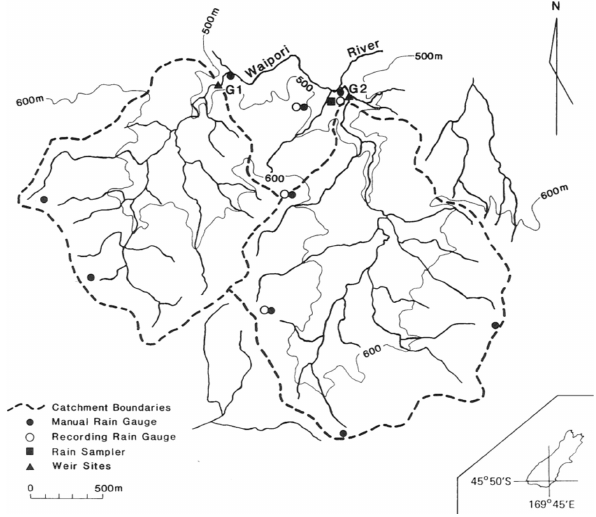
Figure 3. Map of Glendhu Catchments (GH1 and GH2). The inset shows their location in the South Island of New